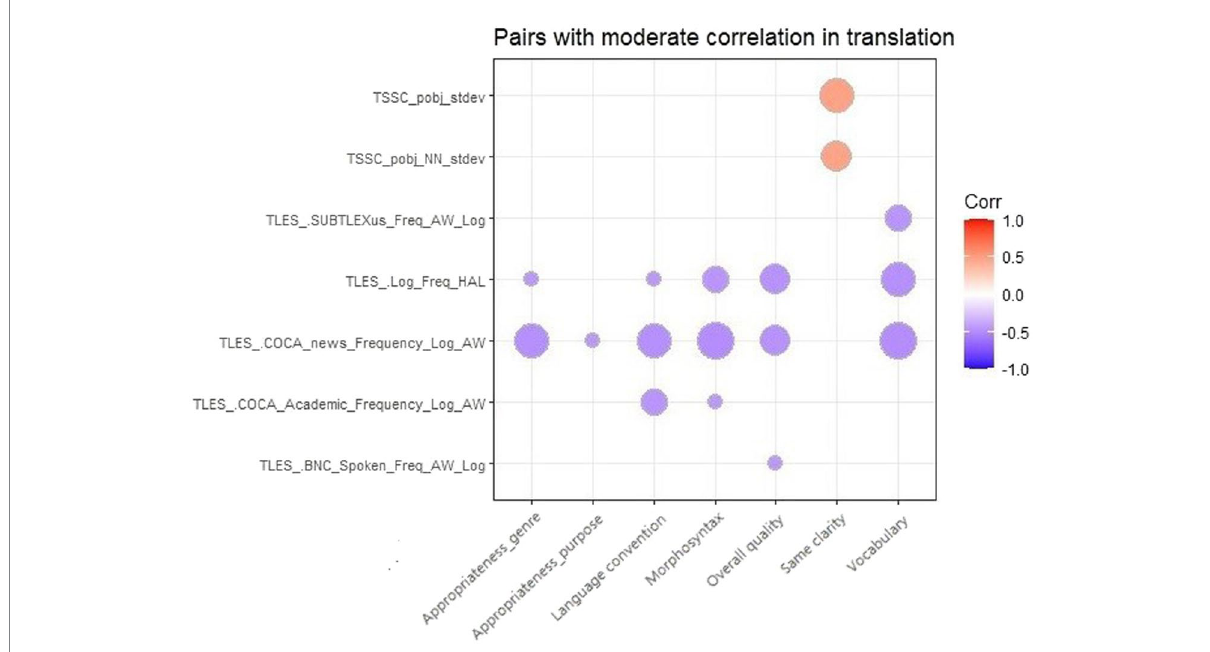
FIGURE 2 17 pairs of NLP indices and translation quality metrics with a moderate